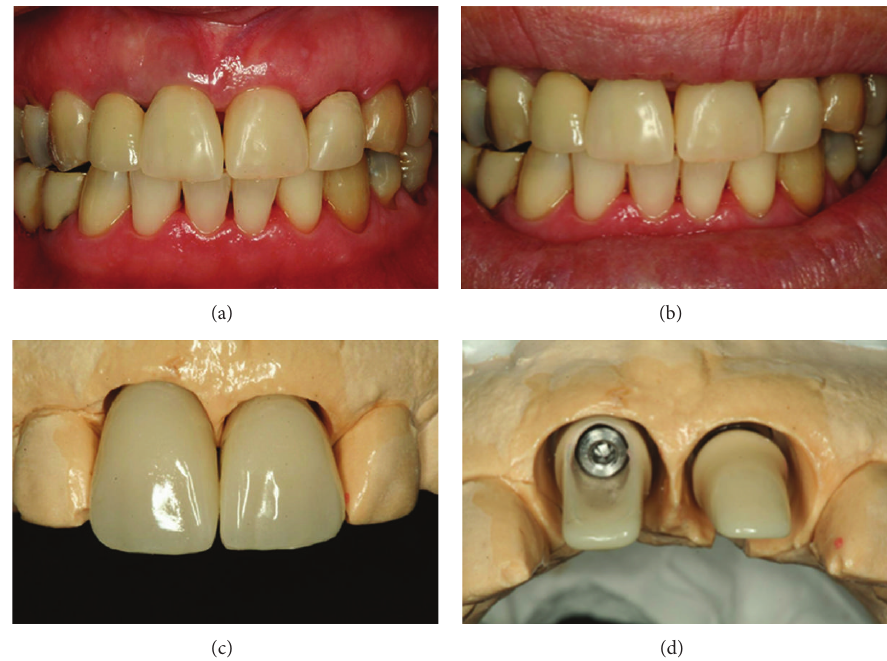
Figure 8: (a, b) 4 months after the implant placement in the left central incisor. (c, d) Application of ceramic Ivoclar press on the abutments to improve the aesthetic